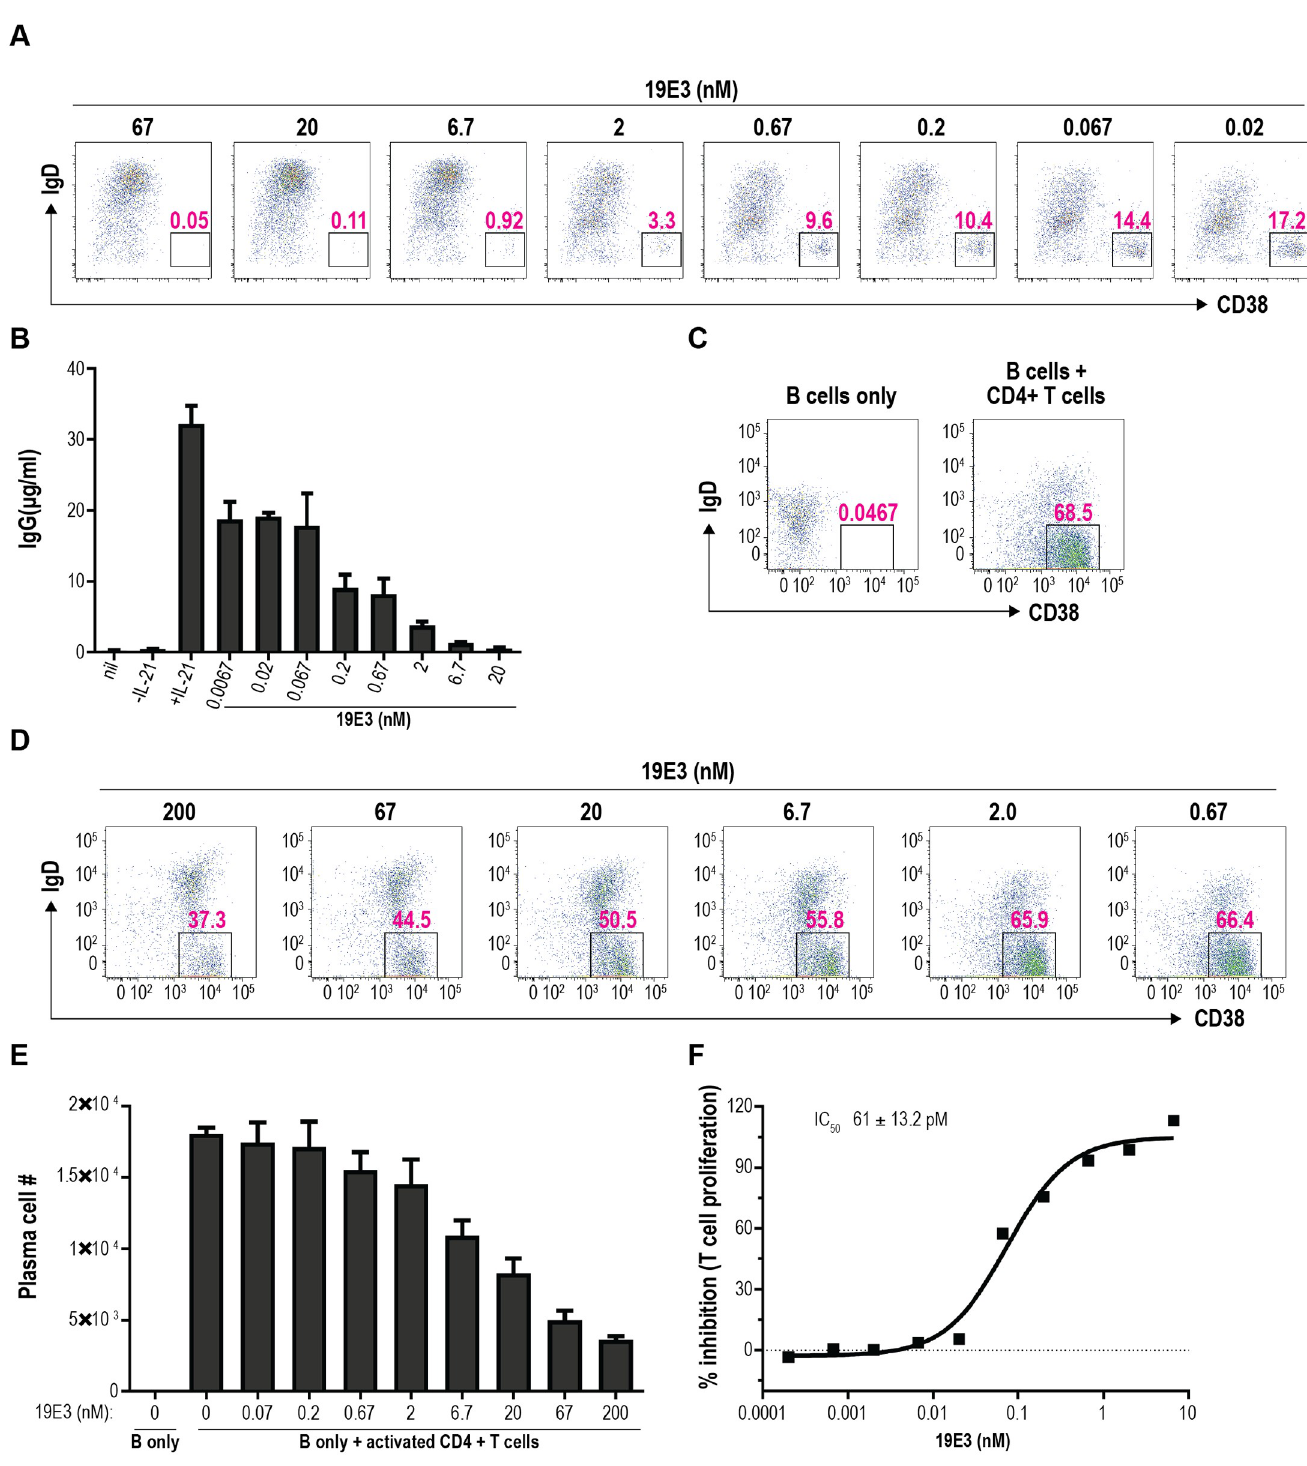
Fig 5. 19E3 inhibition of PC differentiation mediated by recombinant and endogenous IL-21. (A, B) B cells were isolated from human peripheral blood and stimulated with or without recombinant IL-21 in combination with anti-CD40 and anti-IgM. 19E3 was included at the indicated concentrations. (A) PCs were quantified on day 7 by flow cytometry as IgD – CD38 hi cells (percent of PCs in well indicated). All samples were run in duplicate. (B) Supernatants were collected on day 7 and IgG levels were quantified by ELISA. The experiment was performed with 5 unique donors in 3 separate experiments. Results from a representative donor are shown. (C, D and E) Human B cells were co-cultured with anti-CD3/anti-CD28–activated CD4 + T cells in the presence of graded doses of 19E3. After 7 days of